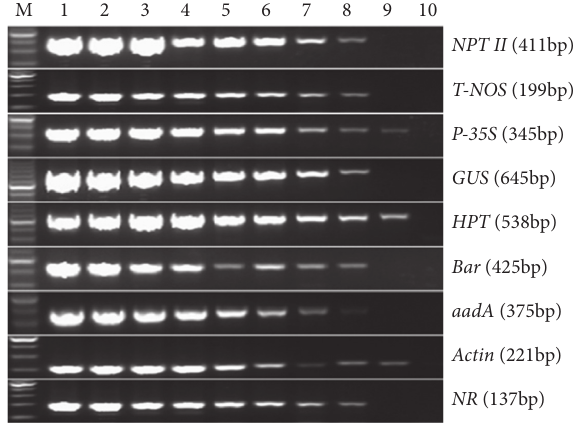
Figure 2: LOD of pGMT27 using qualitative PCR for nine targets. Lane M: TAKARA 100bp DNA ladder; lanes 1–9: 10 6 , 10 5 , 10 4 , 10 3 , 10 2 , 50, 10, 5, and 1 copies/ µ L; lane 10: NTC.